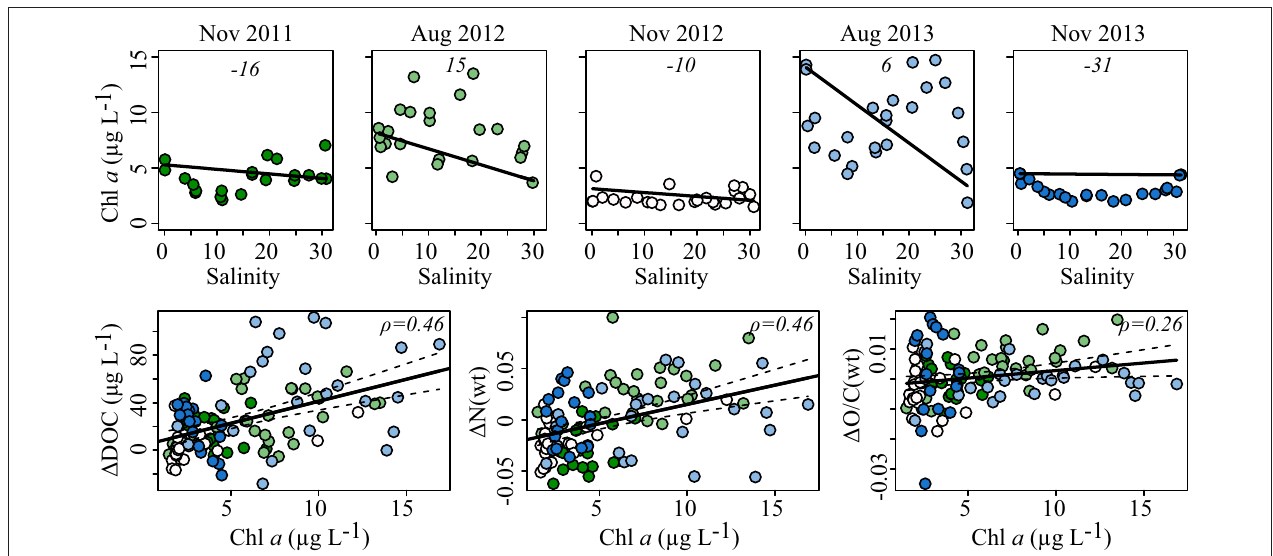
FIGURE 2 | (Top row) Chlorophyll a concentration vs. salinity for all five cruises. Solid lines represent conservative mixing lines calculated using averages of the two samples of lowest and highest salinities, respectively. Numbers in italics denote percentage of deviation between the conservative mixing line and the measured values (see Methods). ( Bottom row ) Chlorophyll a concentration vs. the deviation from conservative mixing of DOC concentration, weighted N content and weighted O/C ratio noted as 1 . The color of the symbols in the bottom row indicates the cruise as defined in the top row. Solid lines represent linear regression, and dashed lines denote standard error. Spearman rank correlations for each parameter vs. chlorophyll a concentration are given. Significance of correlations is p < 0.01.